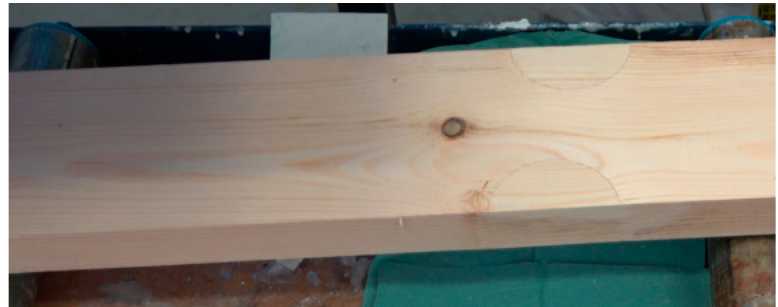
Figure 13. Appearance of lumber with inserts intended for the outer tensile layer.